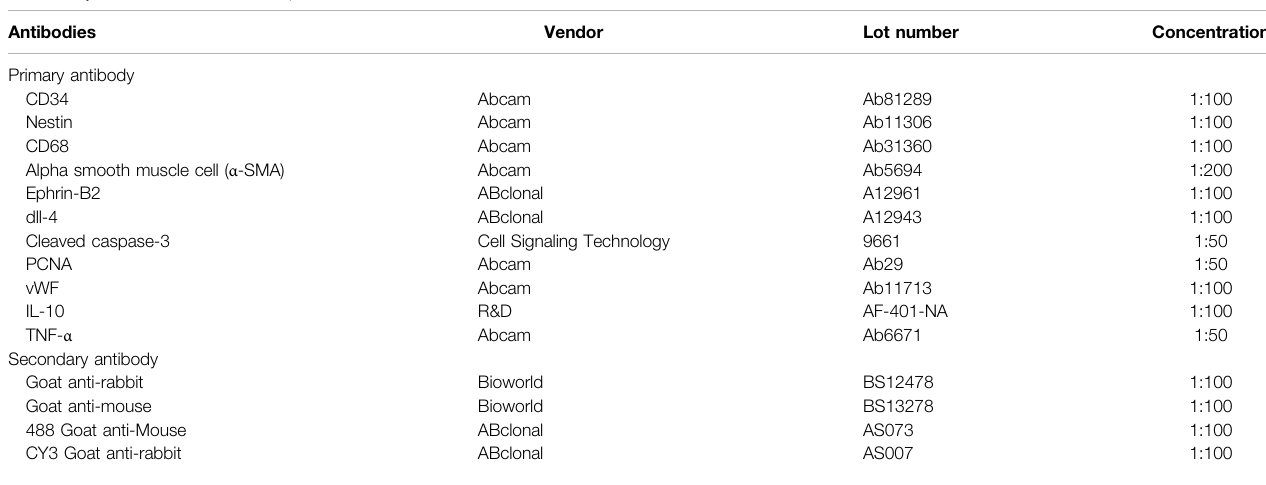
TABLE 1 | Antibodies used in this experiment. Antibodies Vendor Primary antibody